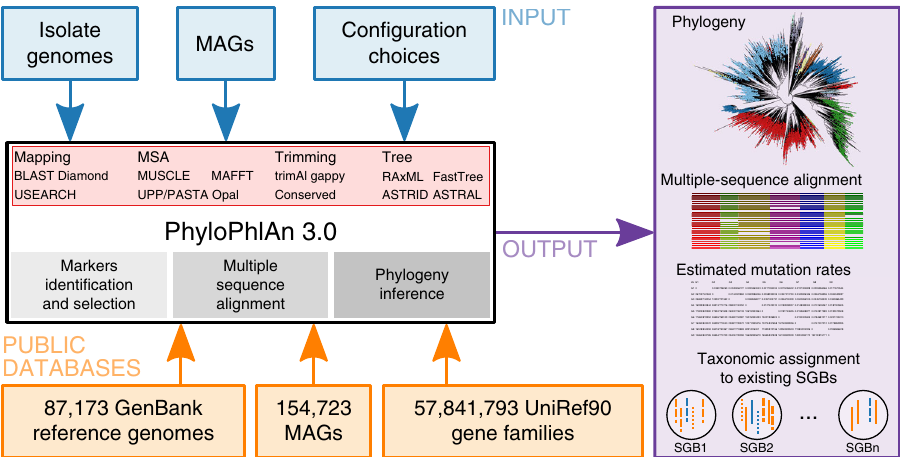
Fig. 1 PhyloPhlAn 3.0 phylogenetically places microbial isolate or metagenomic assemblies. PhyloPhlAn 3.0 provides strain-to-phylum level phylogenies built from newly generated microbial genomes (isolate or metagenomic assemblies) in the context of over 80,000 existing isolate genomes and 150,000 metagenomic assemblies. It automatically selects the most informative loci on a clade-speci fi c basis, handles incomplete or fragmented assemblies, and can be con fi gured to provide the resulting multiple-sequence alignment, estimated mutation rates (optionally), and phylogenetic